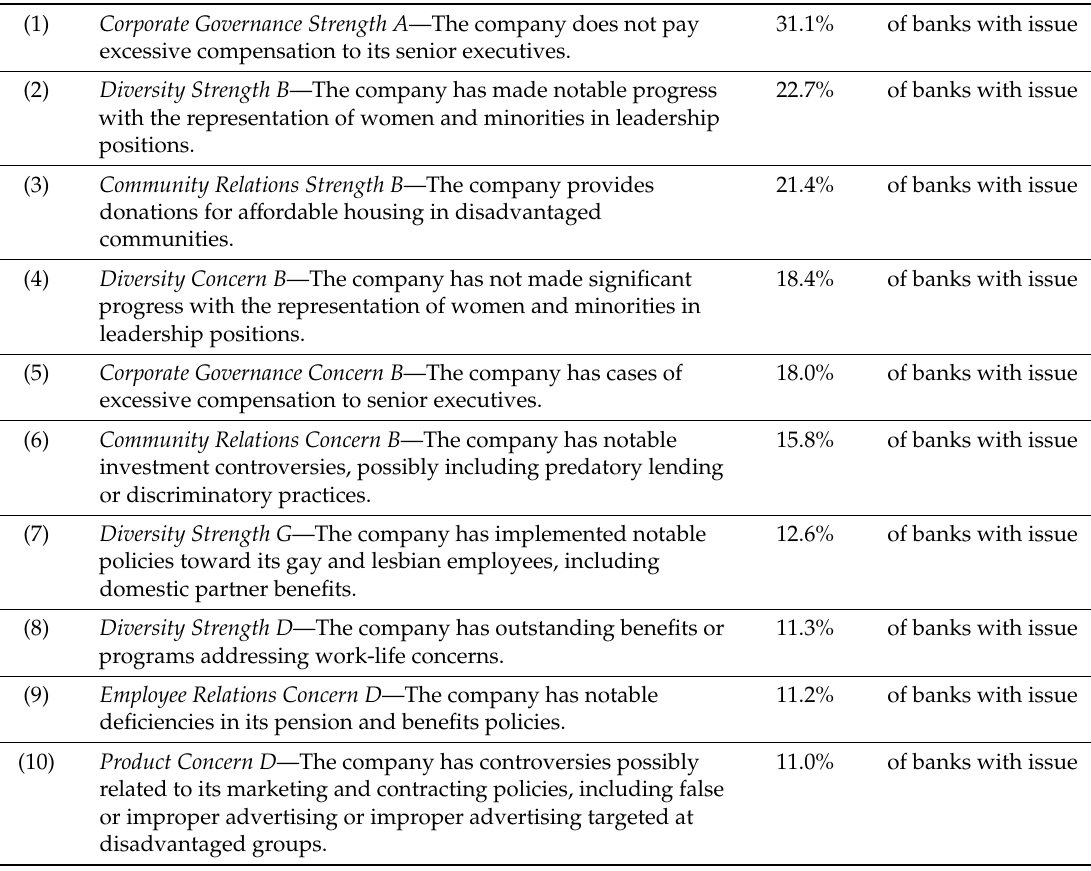
Table A2. Top 10 Most Represented CSR Issues for Bank